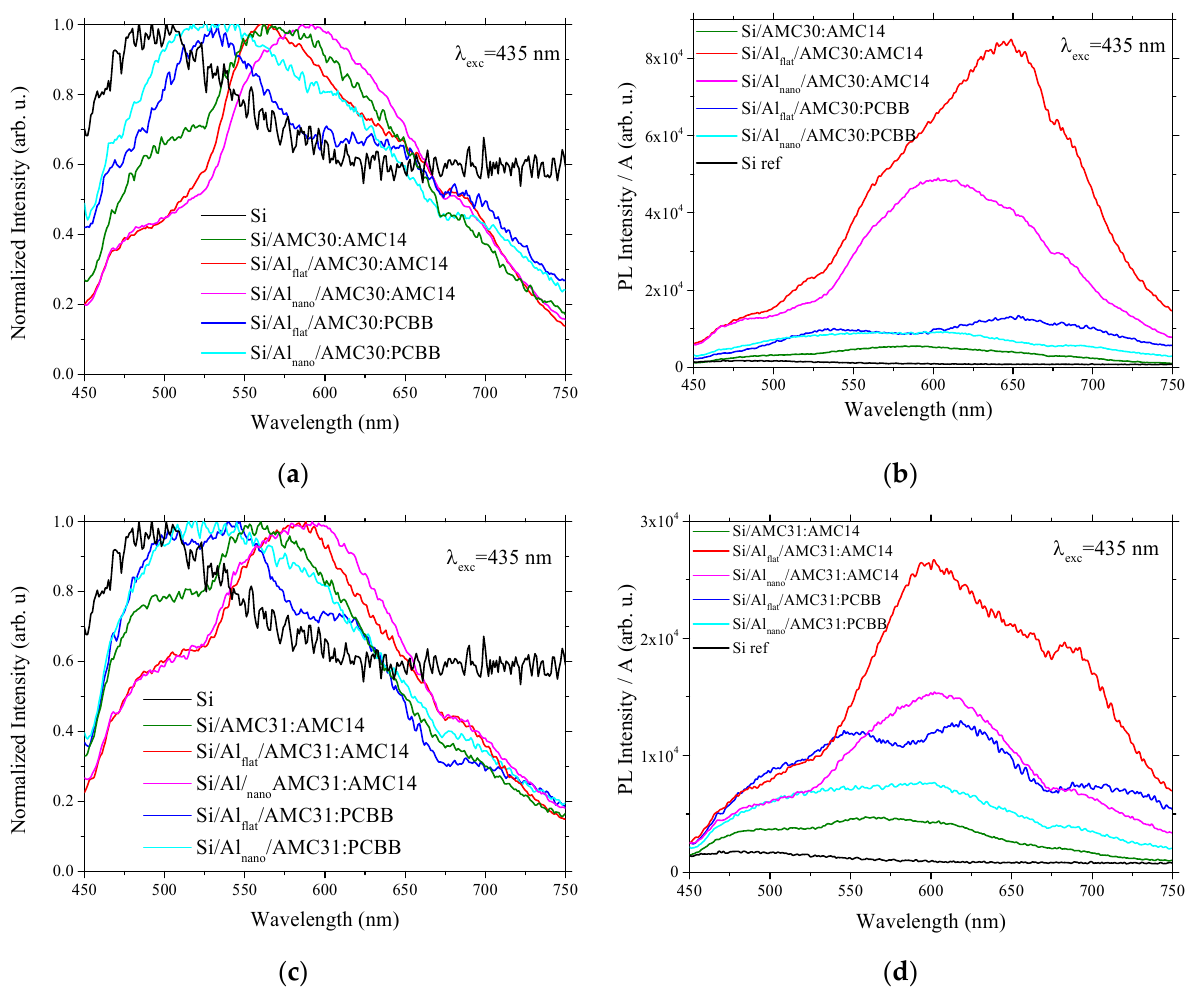
Figure 8. Photoluminescence spectra at excitation with λ = 435 nm of: AMC30:PCBB and AMC30:AMC14 on Al flat and Al nano normalized to PL maximum ( a ); AMC30:PCBB and AMC30:AMC14 on Al flat and Al nano divided by absorbance in reflection ( b ); AMC31:PCBB and AMC31:AMC14 on Al flat and Al nano normalized to PL maximum ( c ); AMC31:PCBB and AMC30:AMC14 on Al flat and Al nano de3vided by absorbance in reflection ( d ). A = Absorbance. The emission spectra of the mixed layers containing AMC30 and PCBB